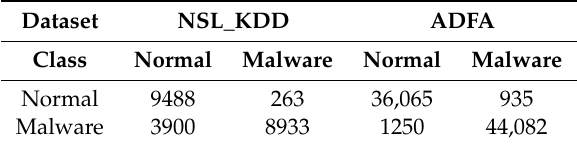
Table 8. Confusion matrix results with the use C5 classifier on KDDTest + and ADFA